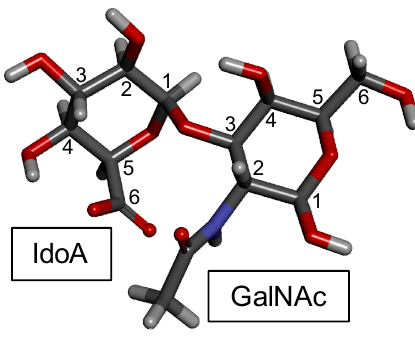
Figure 4. Representative disaccharide unit, IdoA( α 1 − 3)GalNAc, of DS backbones in the 3D stick model. Hydrogens, carbons, oxygens and nitrogens are respectively represented in light grey, dark grey, red and blue. Carbon atoms are numbered according to their positions in the ring. Monosaccharides are indicated accordingly. Model created by the online AMBER/GLYCAM-based carbohydrate builder [40].